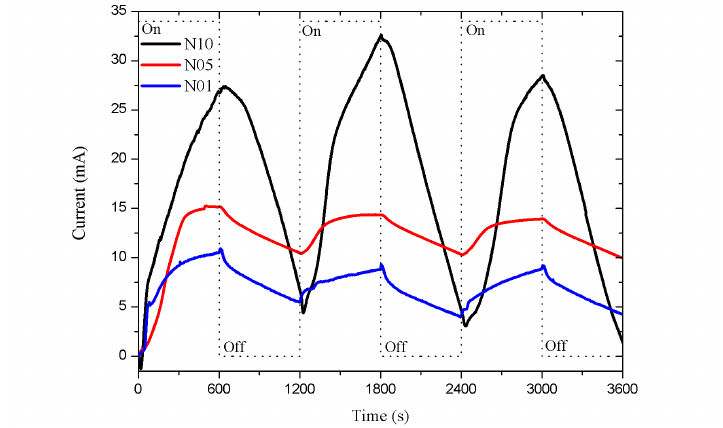
Figure 3. Porous sensor response, Si n-type with 0.0015–0.004 Ω · cm resistivity, connected to a 5 V DC supply. The porosity was 45% and the thicknesses of the porous layers were 1, 5, and 10 µ m; labeled as N01, N05, and N10, respectively. The dead time was around 30 s.